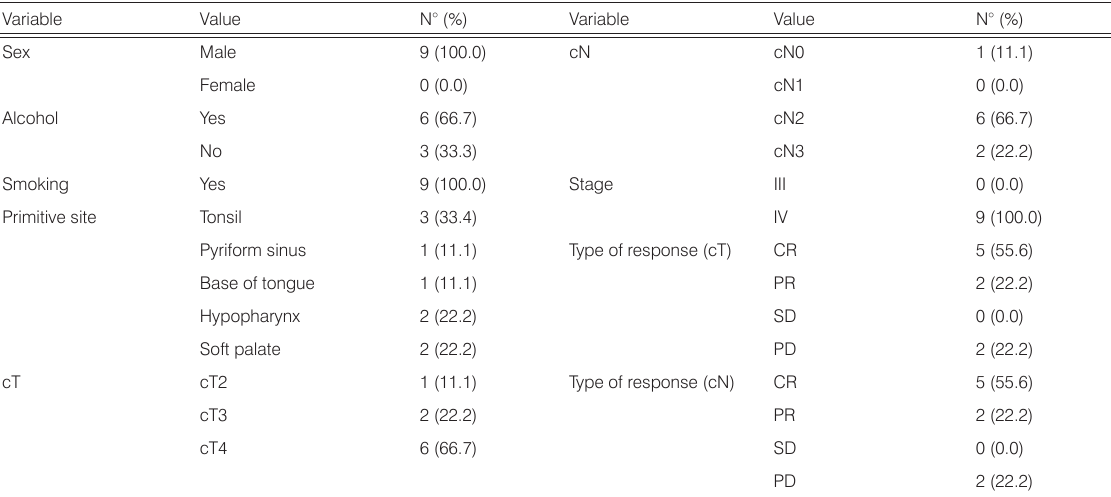
Table 3. The concomitant cetuximab-radiotherapy patients case